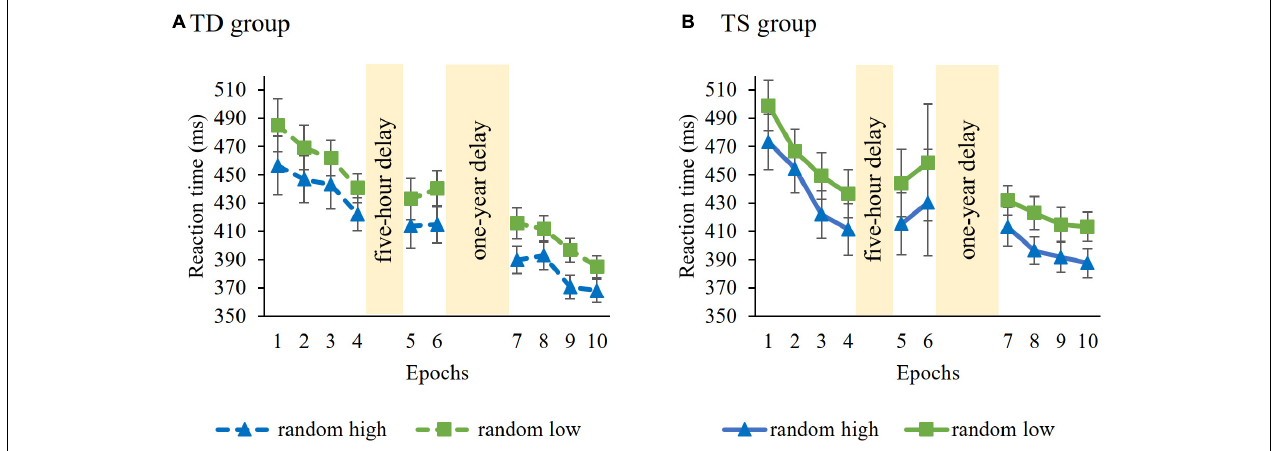
FIGURE 2 | Temporal dynamics of learning of probability-based regularities across epochs and sessions in the (A) TD group and (B) TS group. Dashed lines represent the TD group, continuous lines represent the TS group. RT values as a function of the epoch (1–10) and trial types (random high vs. random low) are presented. Blue lines with triangle symbols indicate RTs on the random high trials, green lines with square symbols indicate RTs on the random low trials. Learning is quantified by the gap between blue and green lines; the greater gap between the lines represents better learning. Error bars denote standard error of